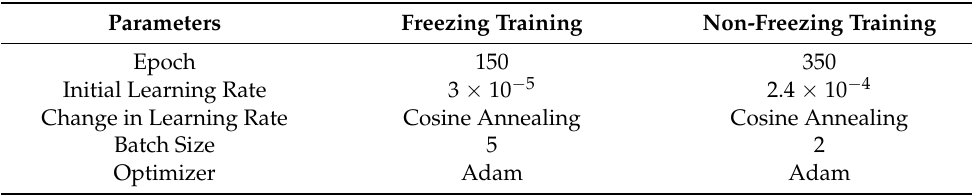
Table 3. Training setting parameters of the